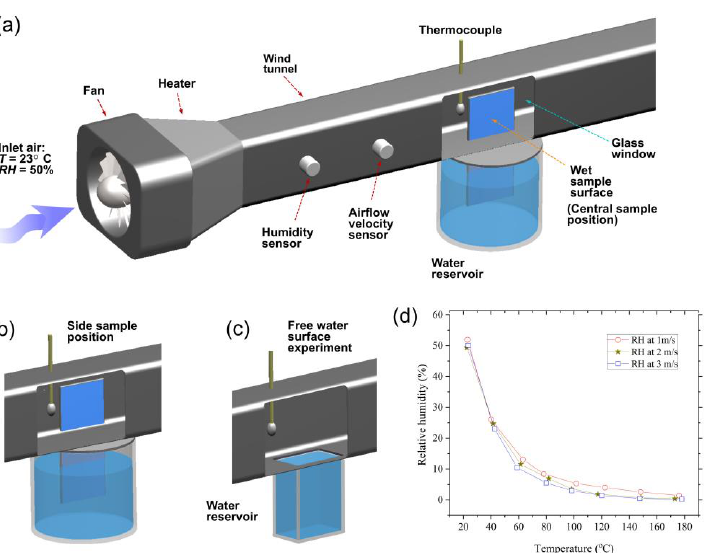
Figure 2. Wind tunnel setup for studying wicking and evaporative functionalities under various airflow conditions. ( a ) Wind tunnel configuration for central sample position in the wind tunnel. ( b ) Side sample position in the wind tunnel. ( c ) Wind tunnel configuration for studying the evaporation rate of free water surface. ( d ) The plot of RH as a function of